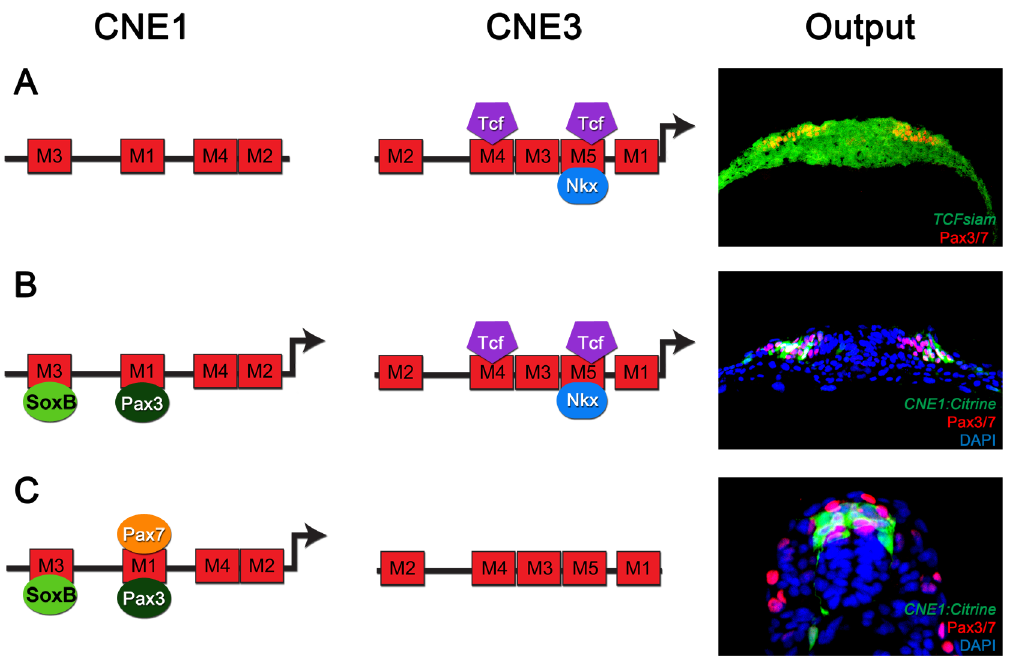
Figure 5. The regulatory logic of Pax3 expression in the neural tube. (A) Pax3 transcription in the developing CNS is induced by the binding of Wnt pathway effectors, such as Tcf3, to CNE3. Motif4 and Motif5 of CNE3 are likely to mediate this interaction as they contain phylogenetically conserved Tcf/Lef binding sites. The HD binding site within Motif5 is required to repress the activity of this enhancer in vivo. Consistent with this, Nkx6.1 binds to CNE3 in EMSAs and represses endogenous Pax3 expression in vivo. This combination of general activation and medial repression establishes the Pax3 expression domain in the lateral region of the neural plate. (B) Once induced, Pax3 protein binds Motif1 of CNE1 to mediate autoregulation. In addition to autoregulation, CNE1 activity might be restricted to neural tissue by SoxB transcription factors. At early stages of development, both CNE1 and CNE3 are transcriptionally active and may act synergistically to establish the Pax3 expression domain. (C) At later stages, when Pax3 expression reaches its maximum in the neural tube, the majority of dorsal progenitors do not experience active Wnt signaling. Furthermore, the Pax3 expression domain does not share a boundary with ventrally expressed Nkx family members at later stages of development. Our data suggests that a combination of autoregulation and Pax7 mediated positive feedback act to maintain Pax3 expression, seen in vivo as